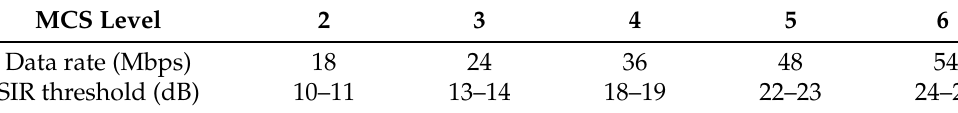
Table 2. Data rate and SIRthreshold with respect to the MCS level.